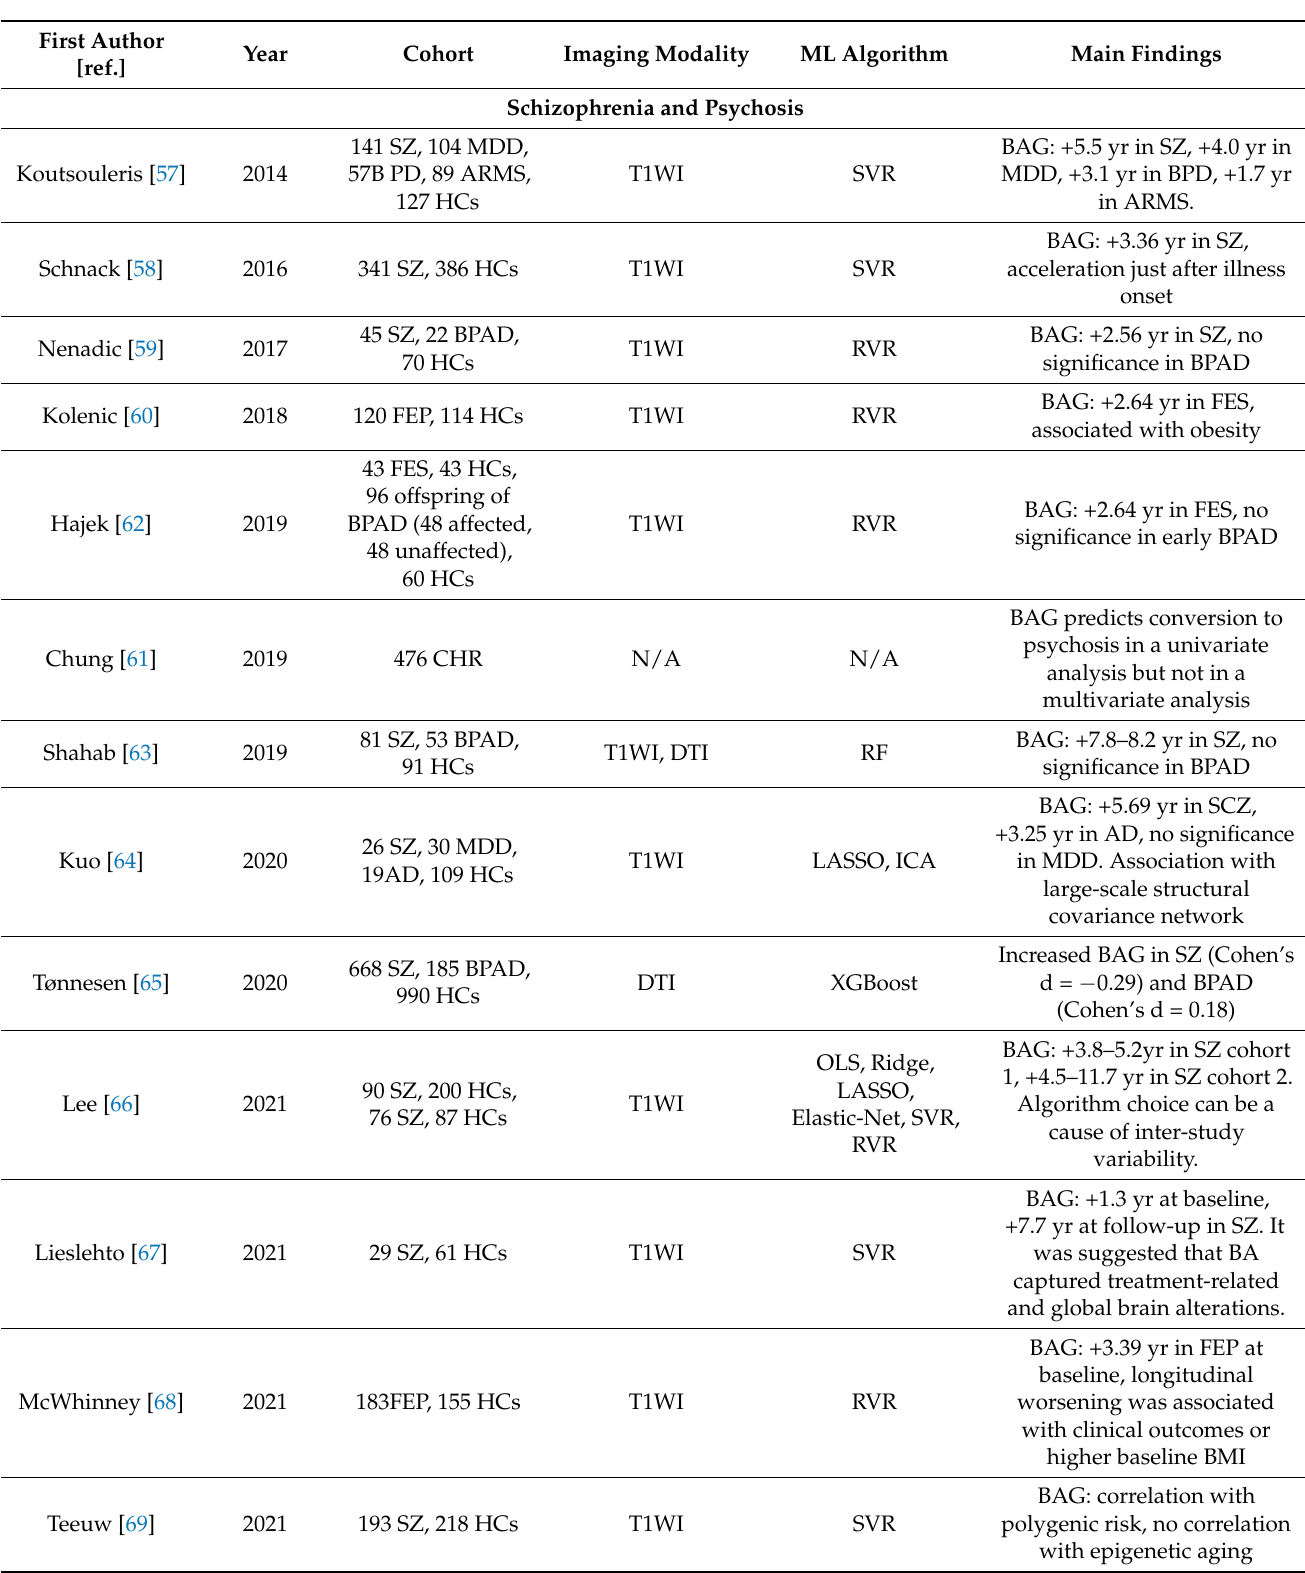
Table 2. Neuroimaging-based brain age studies for psychiatric